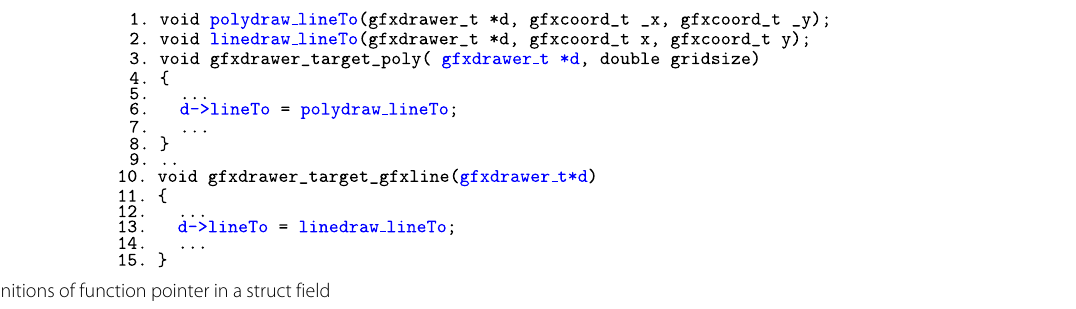
to which function pointers field using an offset as a key for the field. For example, for the function pointer func at line 4 in Fig. 3, we use “ struct.arguments.1